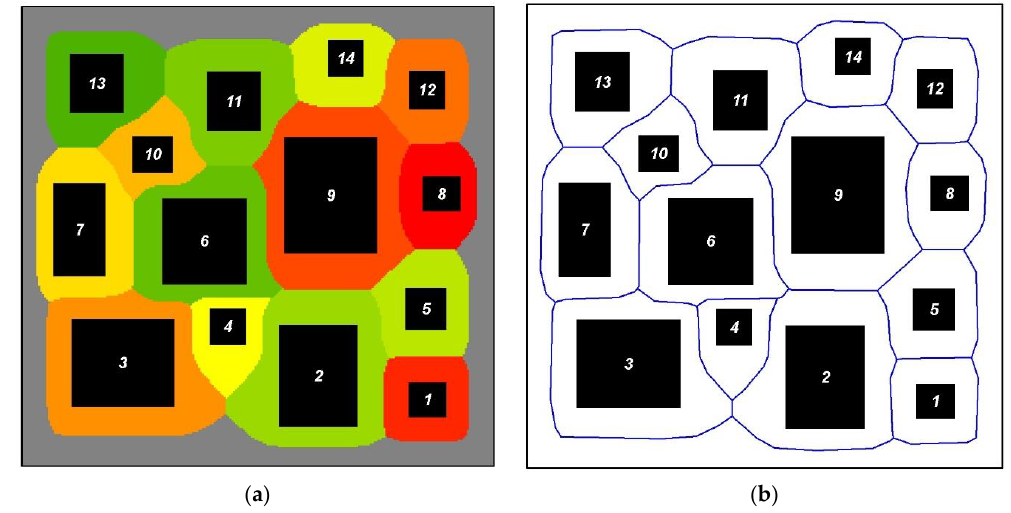
Figure 3. Voronoi Diagrams (colored regions) of 14 obstacles (black rectangles) on the left ( a ) and skeleton (boundaries of Voronoi Diagrams) in blue lines on the right ( b ).